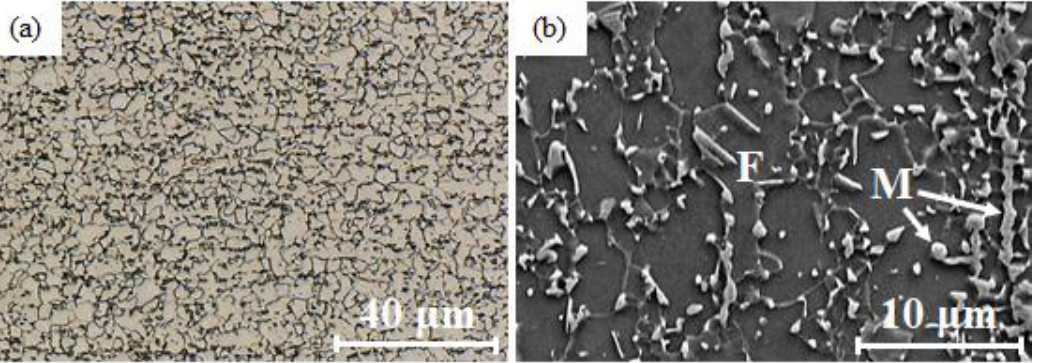
Figure 3. ( a ) LOM and ( b ) SEM images from the as-received microstructure of Ductibor ® 1000-AS (F: ferrite and M: martensite).